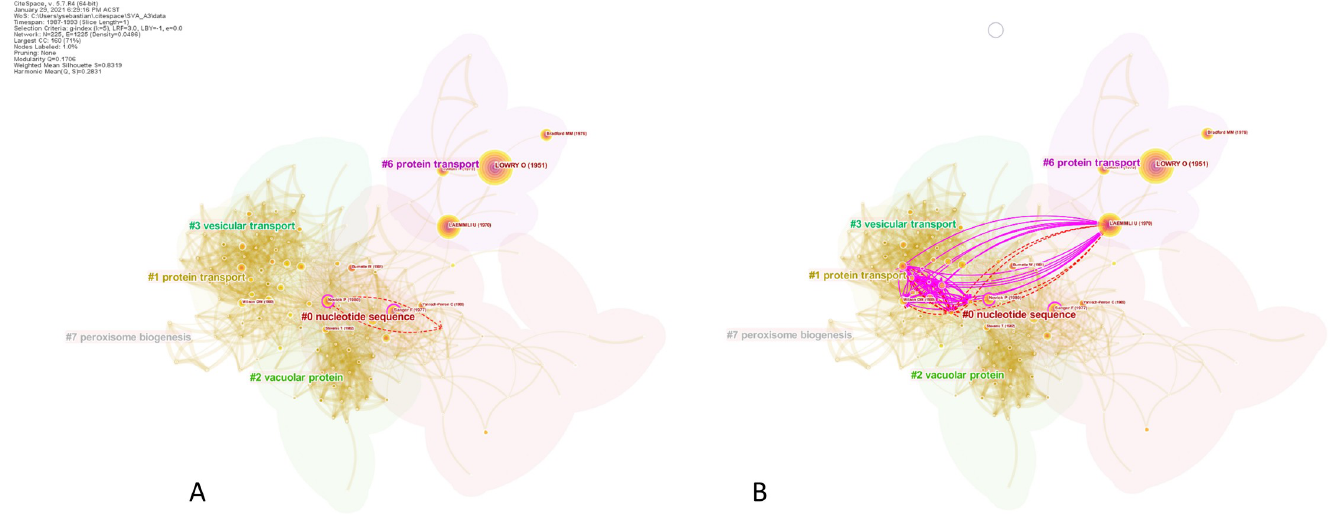
Fig 7. Case 3, Seed 2 ( S 3,2 ). Comparing the structural variations induced by Ohsumi’s papers against the most cited paper in our SVA result set [67] (see Table 7). (A) outlines the novel links induced by S 3,2 [59]. (B) compares the novel links induced by [67]. The underlying network is identical to that in Fig 6.